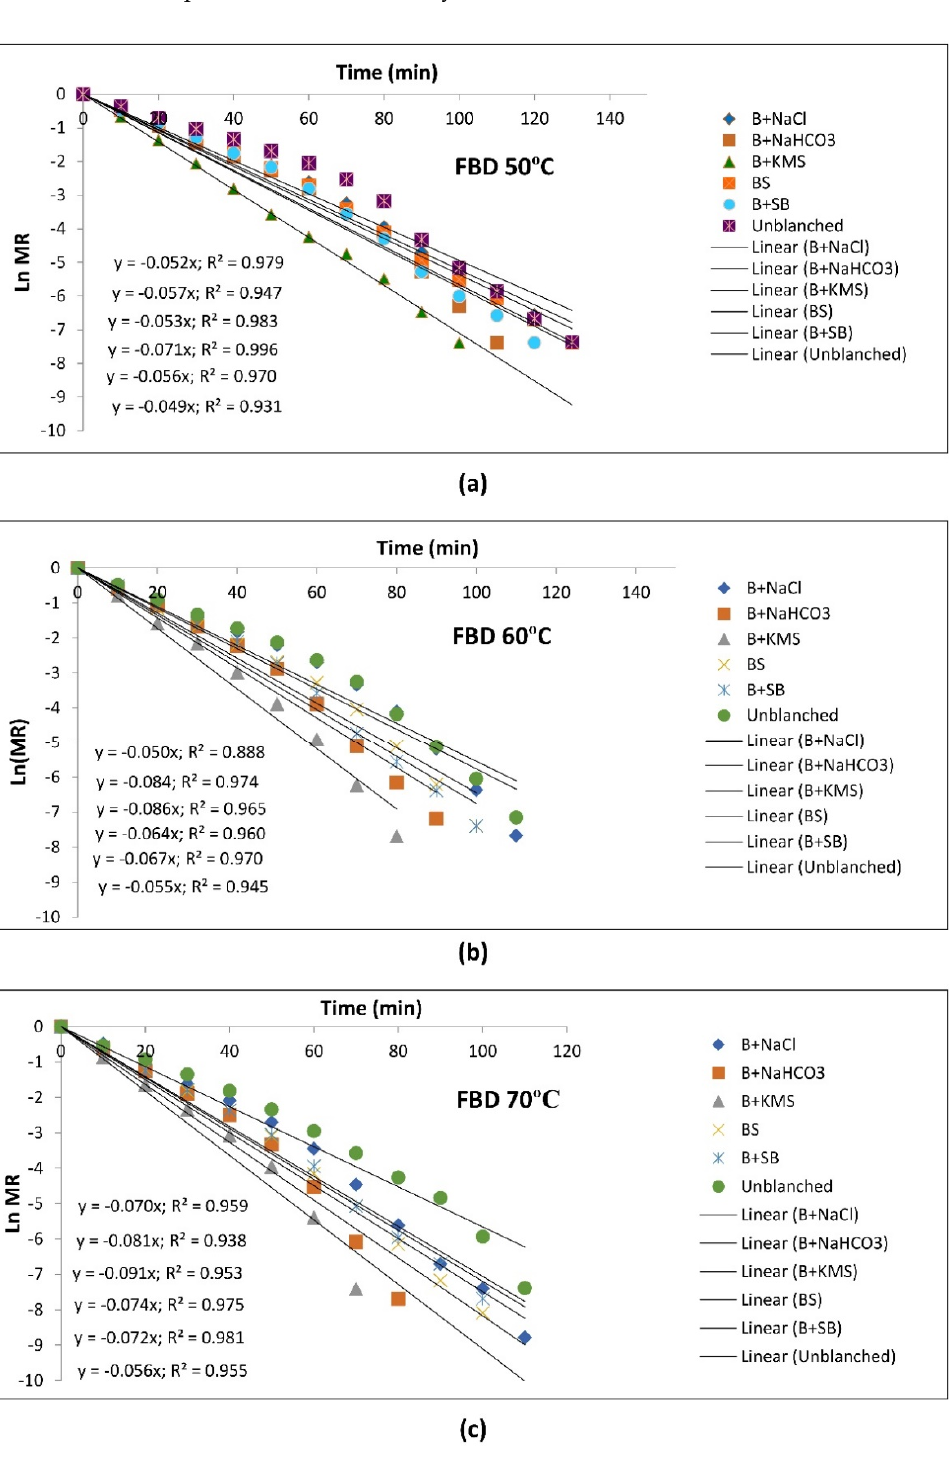
Figure 6. ( a – c ): Plot of Ln(MR) against drying time (min) for calculating effective diffusivity coeffi- cients (D eff ) under various pretreatments in fluidized bed dryer (FBD) at 50 °C ( a ), 60 °C ( b ) and 70 °C ( c ).